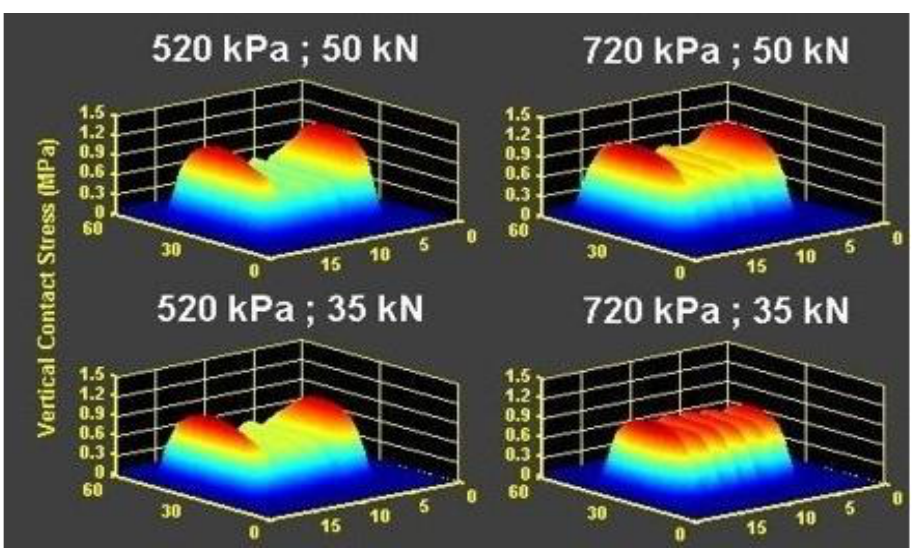
Figure 10. Illustration of capability of SIM measurement of variance in vertical contact stress across tire with variance in tire inflation pressure (kPa) and tire loading (kN).